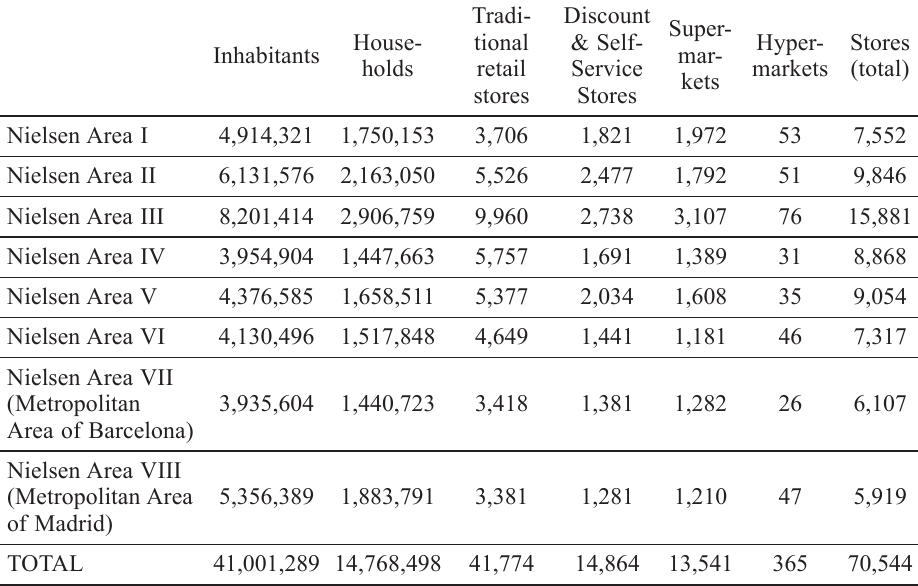
Table 1. Number and retail format of stores in Nielsen areas of the Iberian Peninsula